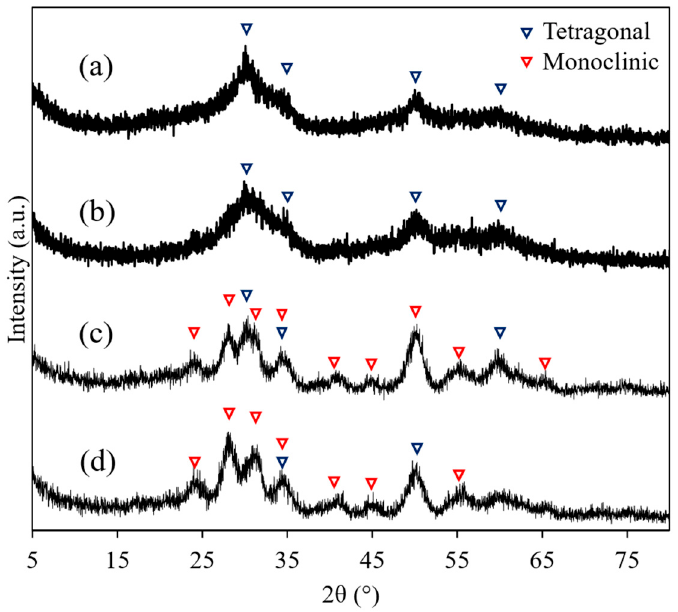
Figure 1. XRD patterns obtained for ZrO 2 nanoparticles synthesized at various temperatures: ( a ) 250 °C, ( b ) 300 °C, ( c ) 350 °C, and ( d ) 400 °C.